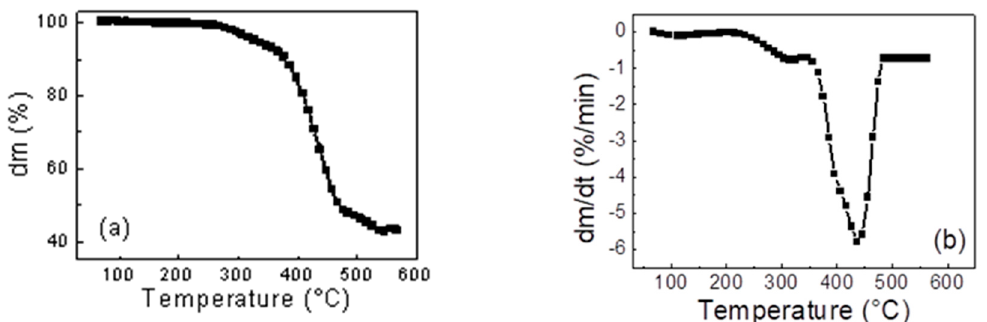
Figure 1. ( a ) TG curve and ( b ) DTG curve of scrap tyre (ST) pyrolyzed at 600 °C and heating rate of 10 °C·min − 1 .